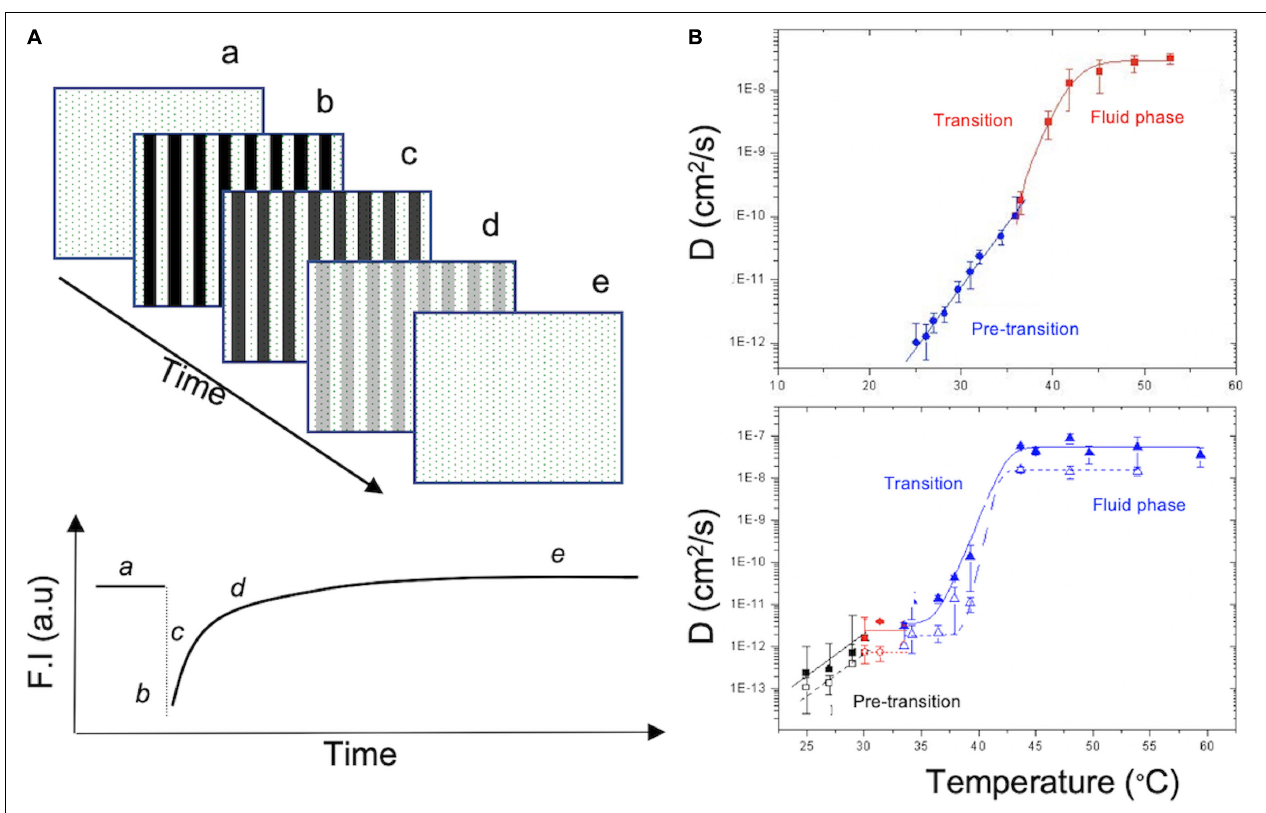
FIGURE 4 | (A) Fluorescence Recovery After Patterned Photobleaching (FRAPP) used to probe phospholipid diffusion in SLB. Fluorescent SLB (a) was photobleached in fringe pattern and the overall intensity decrease (b) . Over time, lipids diffuse, and a recovery of the fluorescence is observed (c–e) . Modified from Harb et al. (2012). (B) Diffusion coefficient of DPPC membrane supported on glass (top) or mica (bottom) measured using FRAPP while varying the temperature of the SLB from 20 to 55 ◦ C. In the bottom graph, full symbols correspond to the distal leaflet and empty symbols correspond to the proximal leaflet due to its interaction with the mica substrate. Slower diffusion is observed at low temperature and it increases with higher temperature until it reaches a plateau during the fluid phase. Reproduced by J. S. with permission (Scomparin et al.,